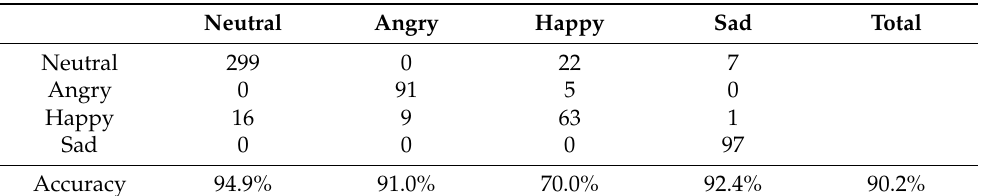
Table 2. SER model emotion categorization results on all the data sets (90.2% accuracy).